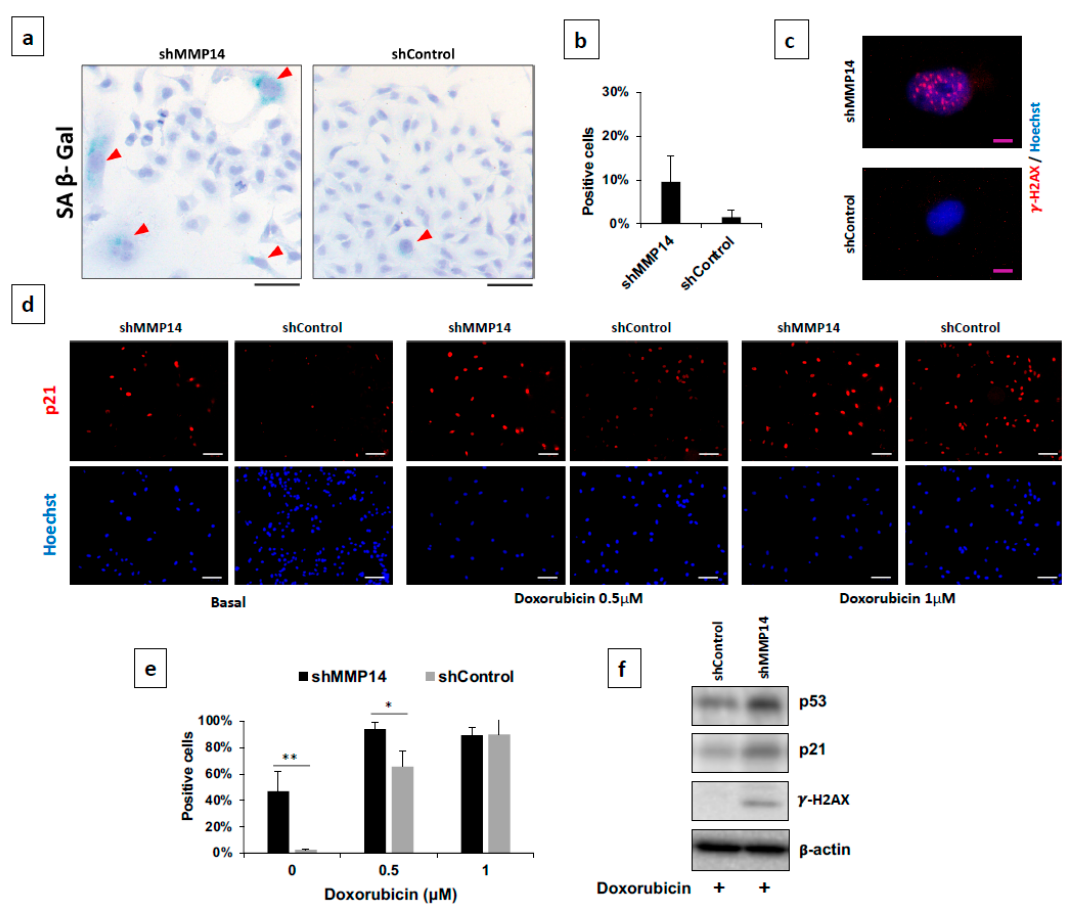
Figure 6. Silencing of MMP14 increases senescence markers on basal conditions and after treatment with doxorubicin. ( a ) Representative micrograph of senescence-associated β -galactosidase (SA- β Gal) staining in shMMP14 cells (Red Arrow- head) versus shControl on basal conditions. Scale bar 100 µ m. ( b ) Percentage of SA- β Gal -positive cells. Graphic of two independent experiments. ( c ) Representative image of γ H2AX foci in the nucleus of shMMP14 and shControl cells on basal conditions. Scale bar 10 µ m. ( d ) Immunofluorescence of shMMP14 cells showing increased p21 on basal conditions and after stimulus with doxorubicin (0.5 or 1 µ M) for 48h. Scale bar 100 µ m. ( e ) Percent of P21 positive cells from two independent experiments. * p < 0.05, ** p < 0.01. ( f ) Western Blot of p21, p53, and γ H2AX after doxorubicin 1 µ M treatment of shMMP14 and shControl cells. Loading control was run on the same blot of p53.